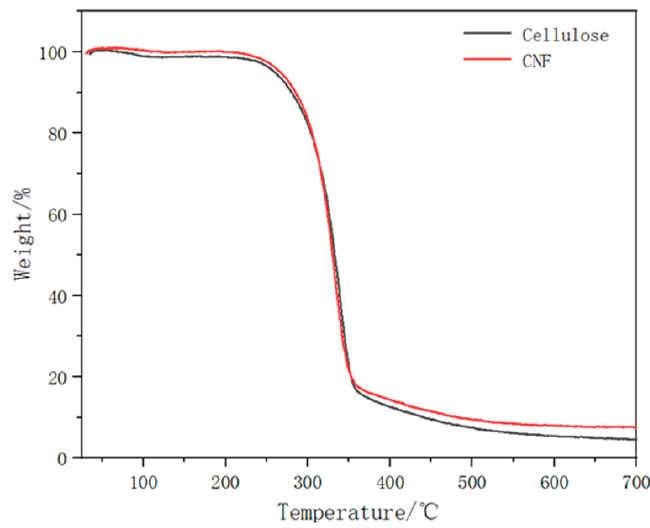
Figure 3. TG curves of cellulose and CNF from durian rinds. CNF suspension was diluted to different concentrations and placed in sample bottles at room temperature for 1 month to evaluate dispersion and stability. It is seen from Figure 4A that the samples of various concentrations were able to disperse uniformly at first. After standing for one month, as shown in Figure 4B, no obvious coagulation phenomenon happened. All samples showed good stability. Inverting the samples as shown in Figure 4C, CNF suspensions with 0.1% and 0.25% concentration still had strong fluidity, while the 0.5% sample had weakened fluidity. Moreover, the 1% sample had no fluidity at all and formed gel. This was attributed to the high aspect ratio of CNF. When the concentration in- creased to 0.5%, CNFs aggregated with each other under the interaction of hydrogen bonds, and the mobility decreased. As the concentration increased to 1%, a three-dimensional network structure formed, resulting in the loss of fluidity of the CNF suspension and the formation of gel. In addition, the zeta potential of the 0.1% CNF suspension was as low as − 63 mV, which also indicated that the CNF suspension had excellent stability and was negatively